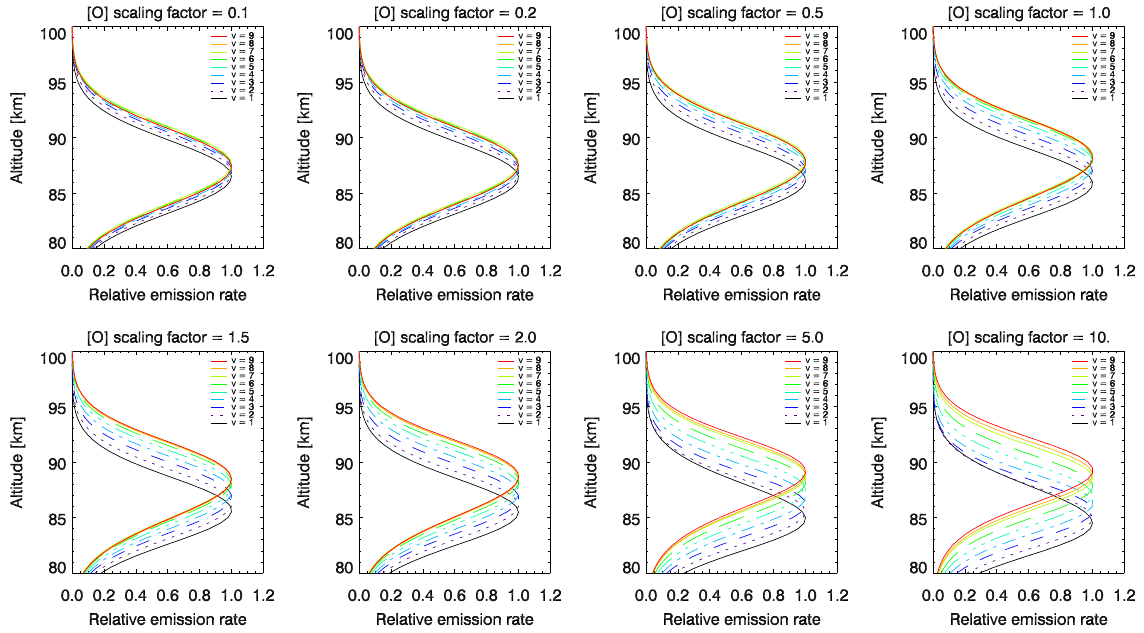
Fig. 9. Sensitivity of the modelled vertical emission rate profiles to the atomic oxygen profile. The standard MSIS atomic oxygen profile is scaled with constant factors varying between 0.1 (top left panel) and 10 (bottom right panel). The rate constants for quenching by atomic oxygen and molecular oxygen are the corrected values published in Xu et al. (2012).